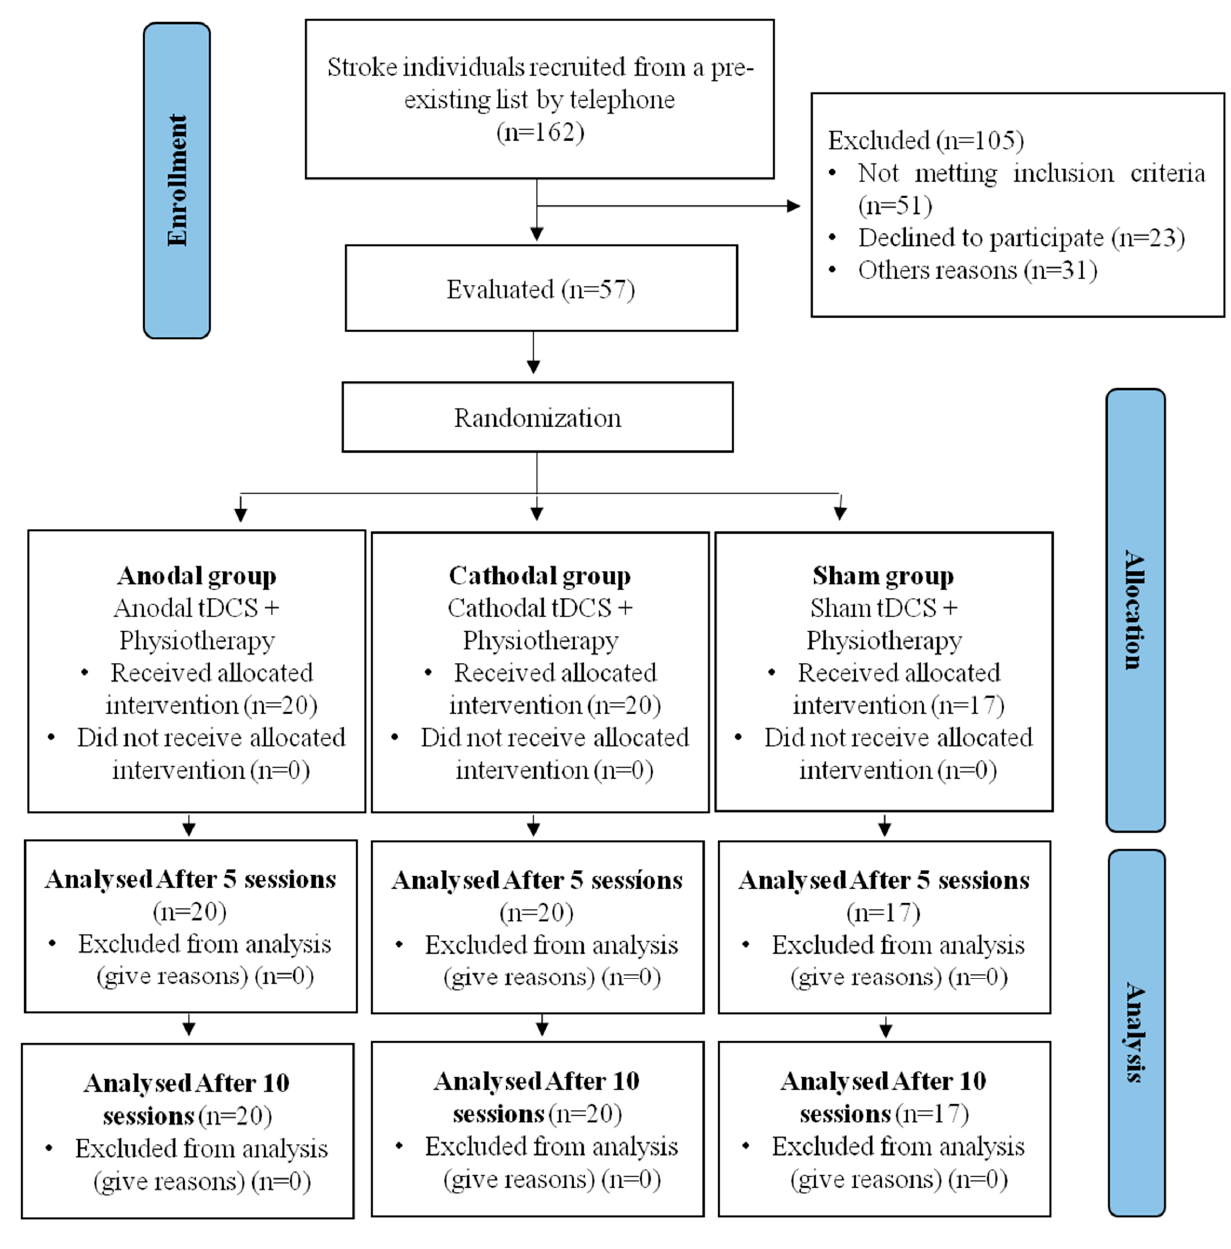
Figure 2. Study flowchart. Table 1. Characterization of the study